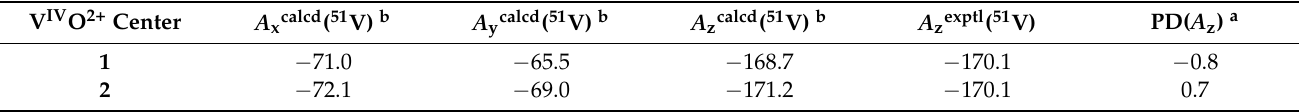
Table 4. Experimental and calculated hyperfine coupling constants for [(V IV O) 2 (L4) 2 (H 2 O) 2 ].